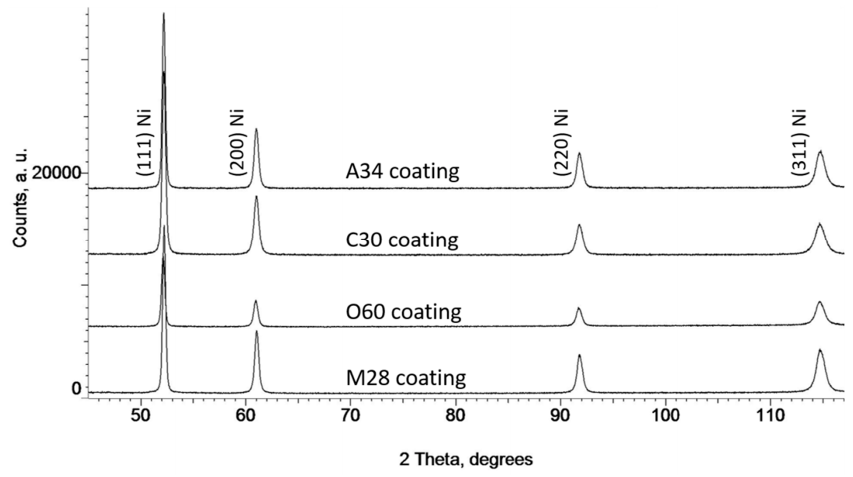
Figure 6. X ‐ ray diffraction patterns obtained for both the cold ‐ sprayed nickel coatings. Figure 6. X-ray di ff raction patterns obtained for both the cold-sprayed nickel coatings.